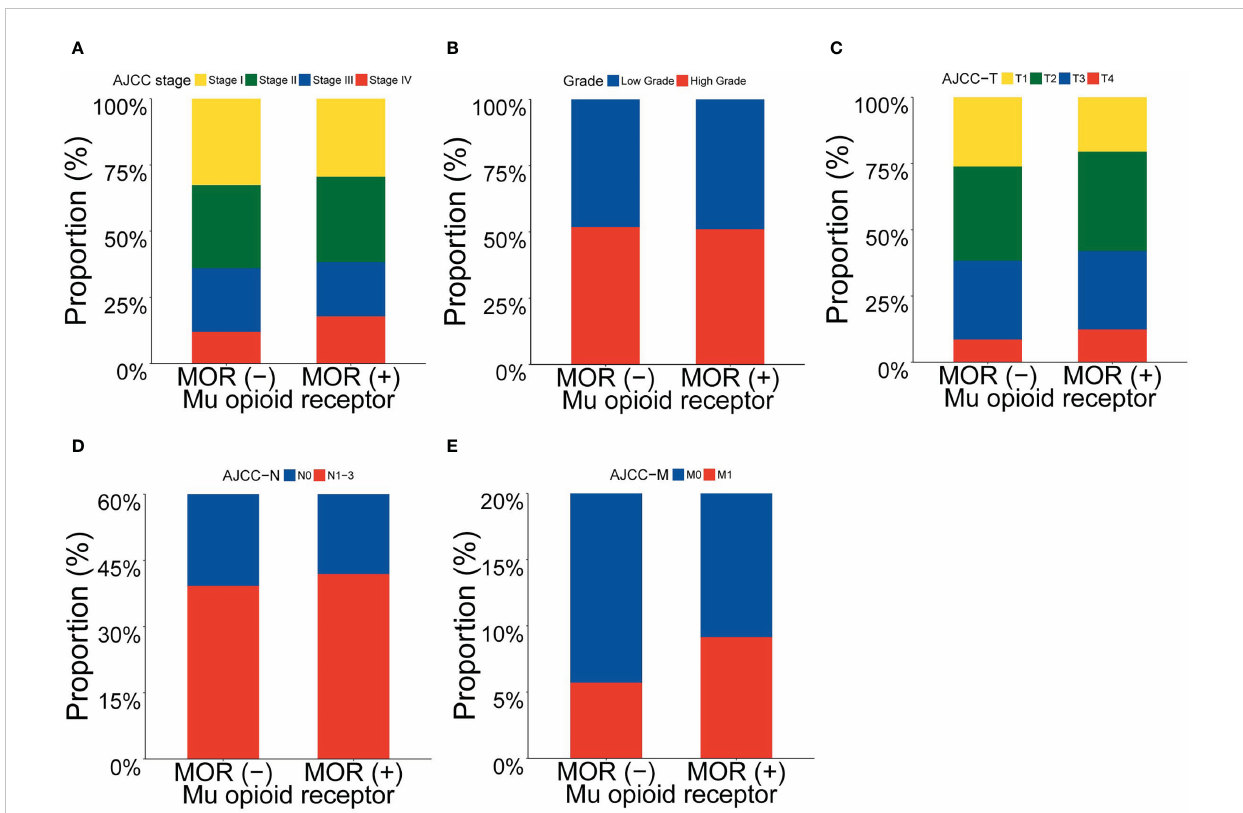
FIGURE 1 Proportion of clinicopathological features according to MOR mRNA expression. Footnotes: Proportion of (A) AJCC stage, (B) grade, (C) AJCC T stage, (D) AJCC N stage and (E) AJCC M